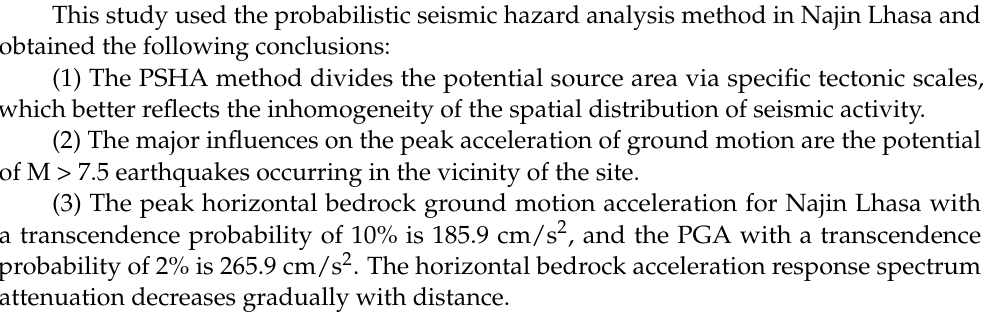
Figure 7. Attenuation curve of the response spectrum of horizontal bedrock acceleration (epicentral distance R = 100 km).